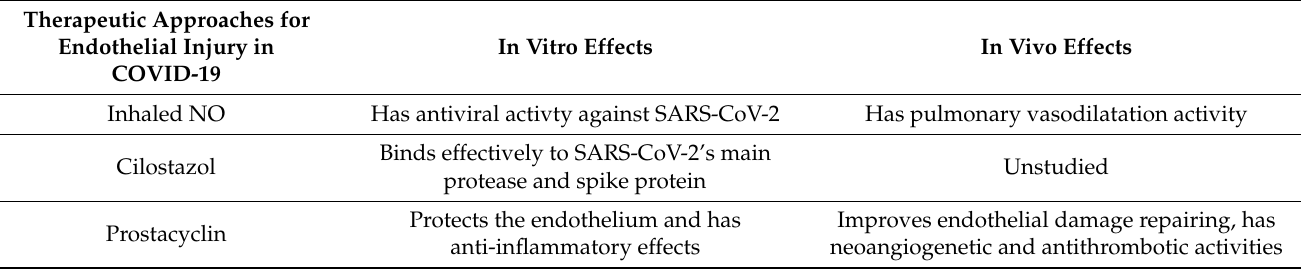
Table 2. The effects of therapeutic approaches that target endothelial injury in